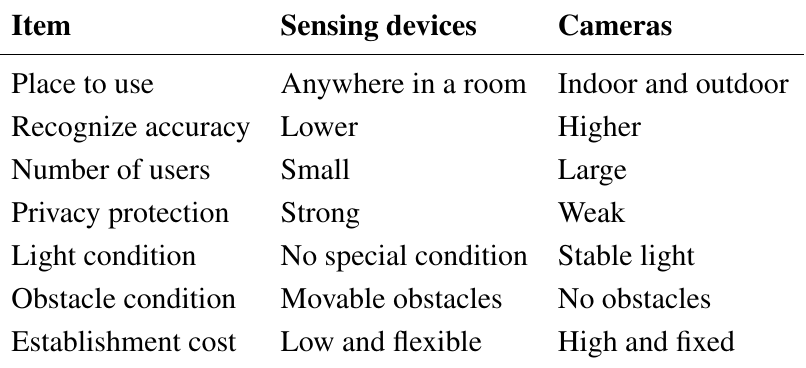
Table 1. Differences between cameras and sensing